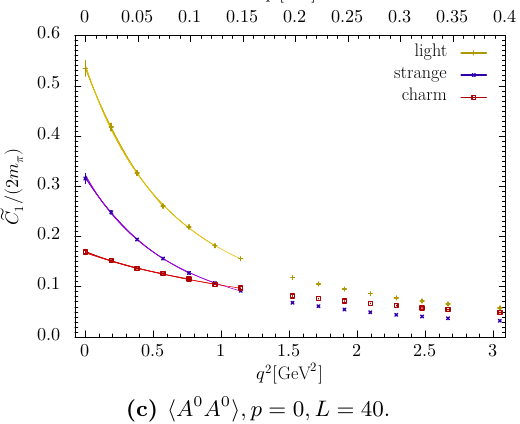
e C 1 = (2 m (cid:25) ) are labelled by \4pt (cid:0)